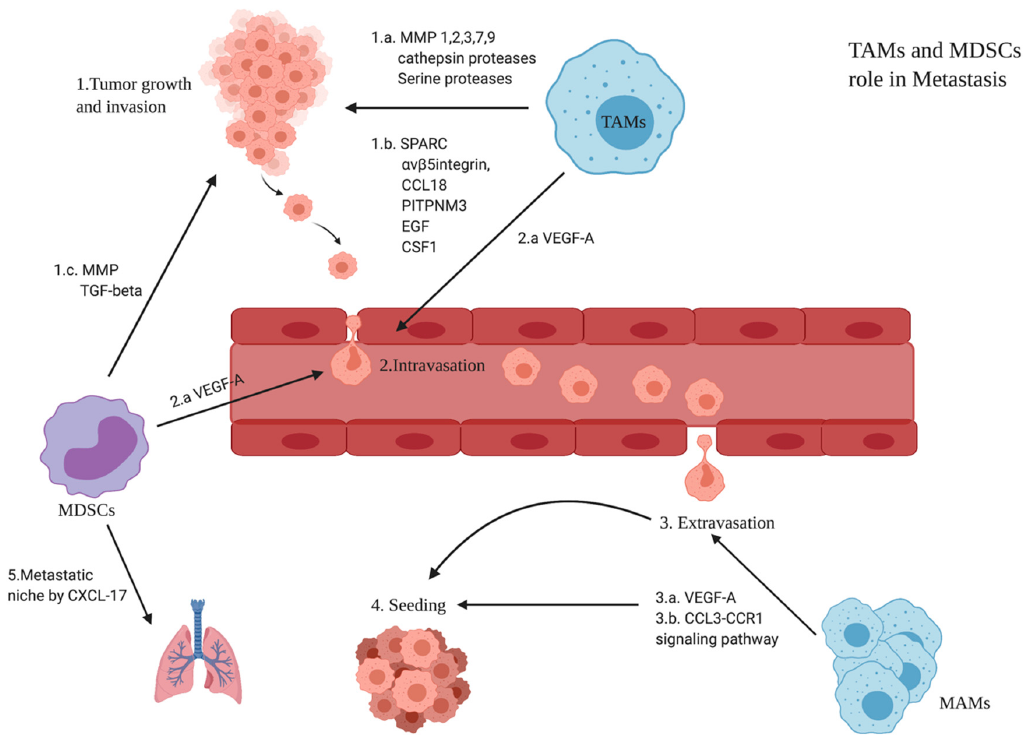
Figure 3. Role of TAMs and MDSCs in metastasis : 1. Tumor growth and invasion. 1.a. TAMs produce MMPs (MMP1/2/3/7/9) and cathepsin. 1.b. Chemokines such as acidic and rich in cysteine (SPARC), chemokine (C-C motif) ligand 18 (CCL18), α v β 5 integrins, phosphatidylinositol transfer protein 3 (PITPNM3), epidermal growth factor (EGF), EGF receptor (EGFR), colony-stimulating fac-